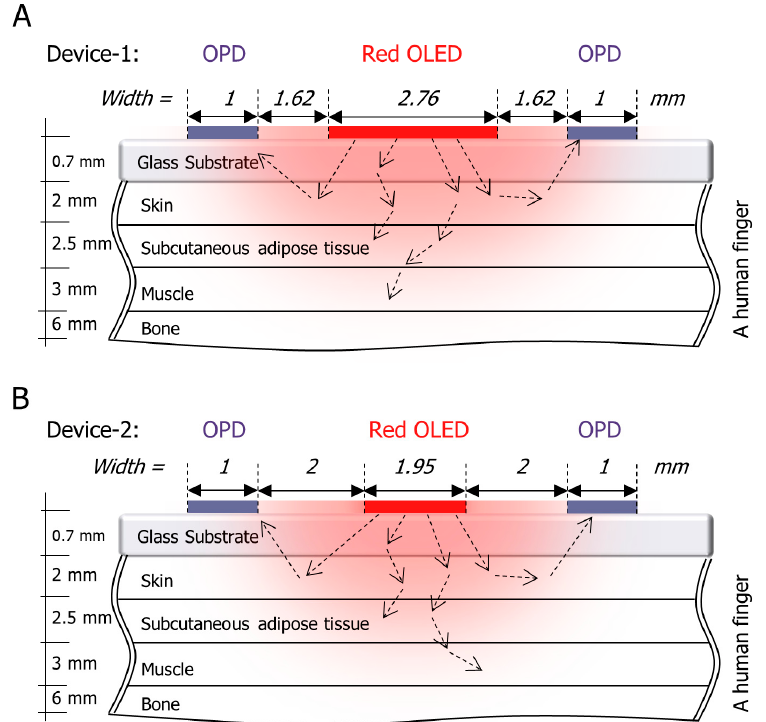
Figure 3. A simplified finger schematic with the organic light-emitting diode (OLED) as the light source and the organic photodiodes (OPDs) as the surface receiver for ( A ) Device-1 and ( B ) Device-2. Table 1. Summary of the approximated optical parameters of a human finger.